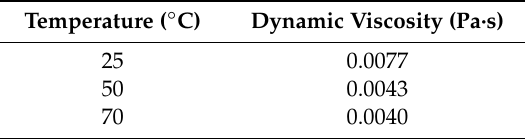
Table 2. The e ff ect of temperature on the dynamic viscosity of the used mineral